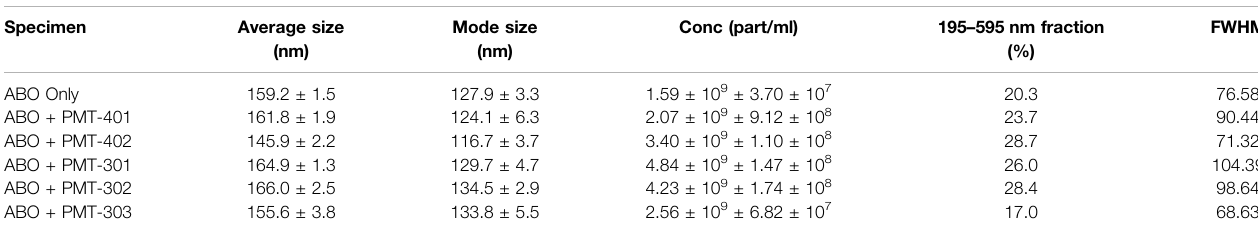
TABLE 2 | Calculated particle parameters from NTA analysis of A β O samples.